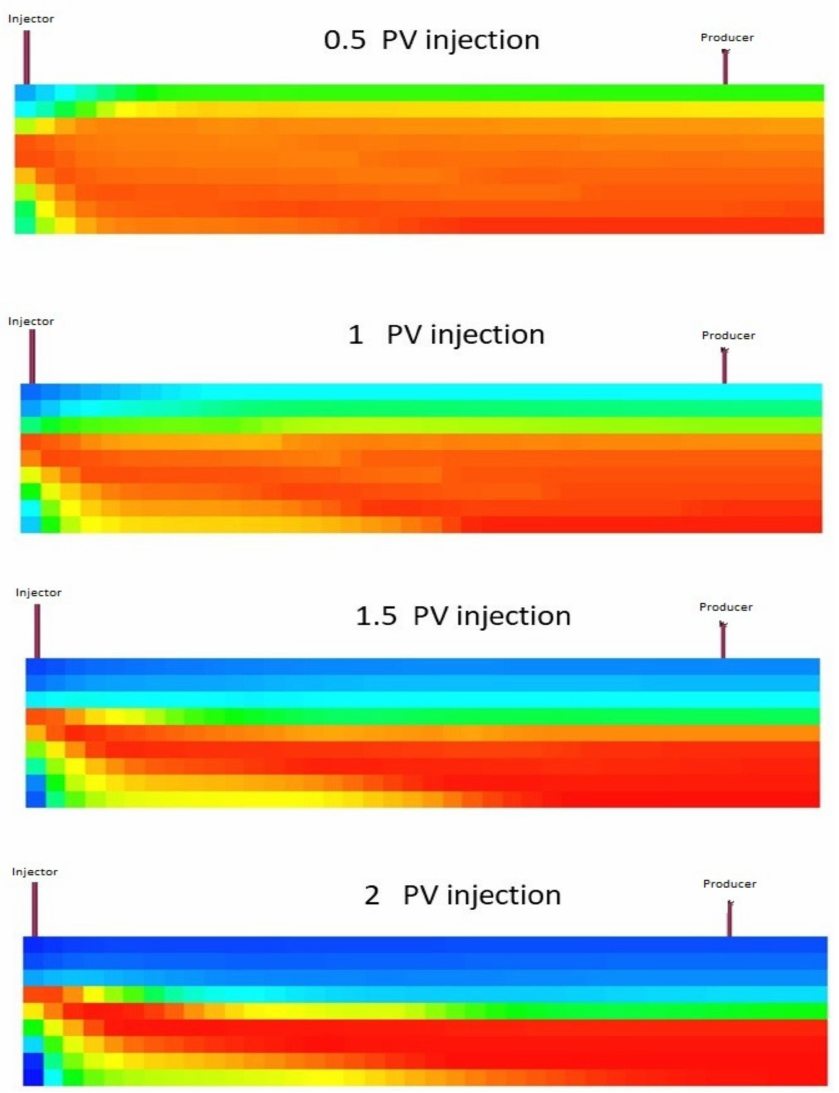
Figure 14. Saturation profile for gas injection for various PV injections (blue for low and red for high oil